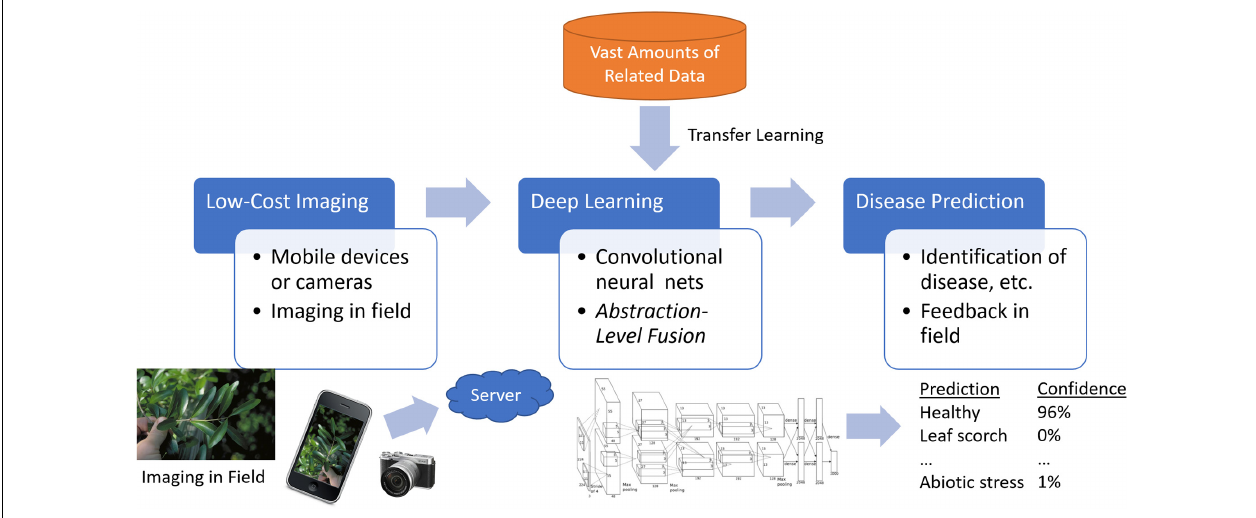
FIGURE 1 | General system overview. A picture of an affected leaf is processed remotely by a server using deep learning. The user receives a report on the diagnosis of the specimen in the